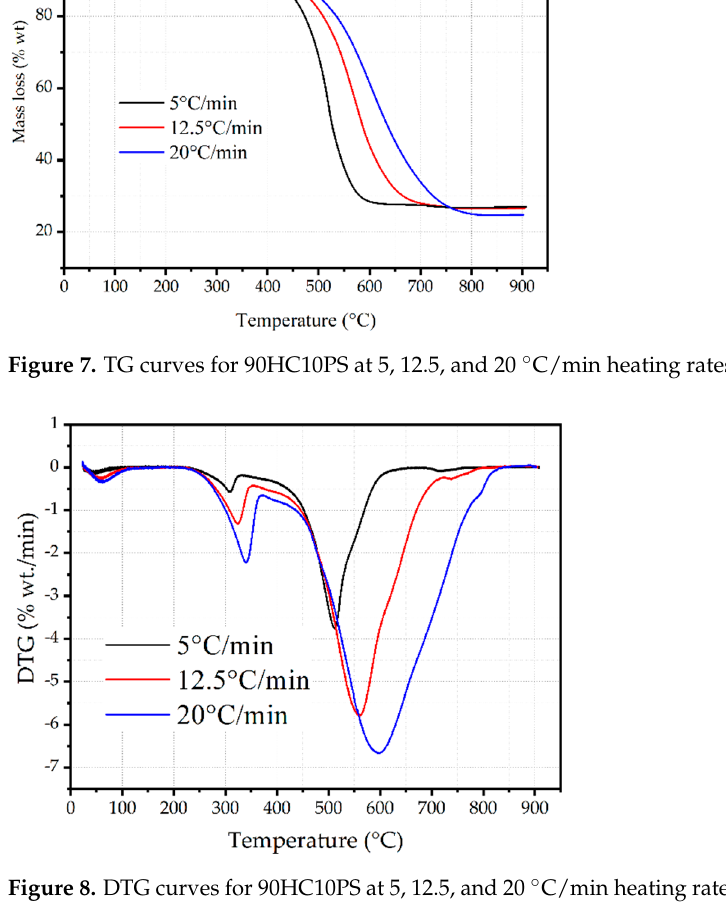
Figure 8. DTG curves for 90HC10PS at 5, 12.5, and 20 °C/min heating rates under an air atmosphere.